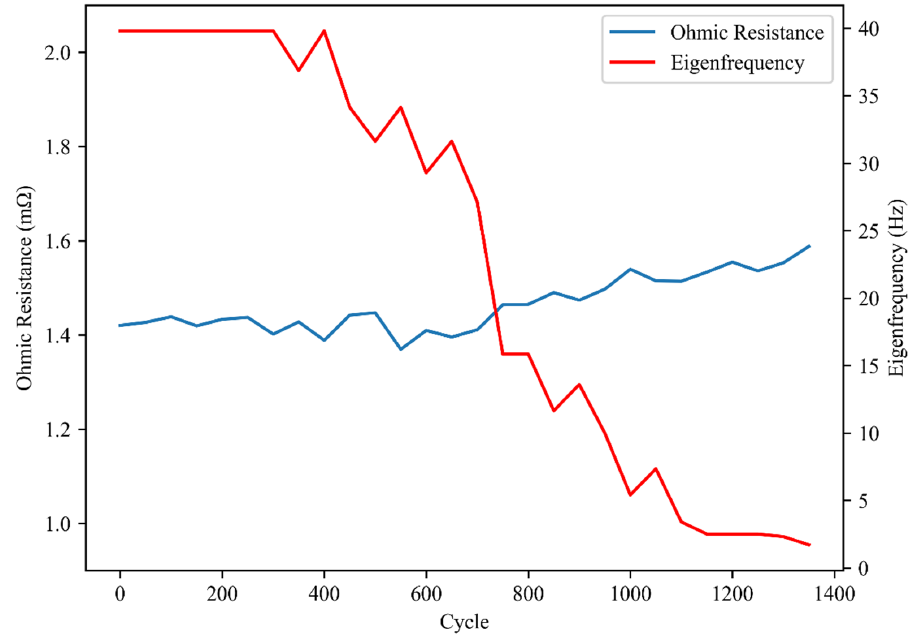
Figure 14. Changes of ohmic resistance and eigenfrequency of cell #7 during aging cycles.